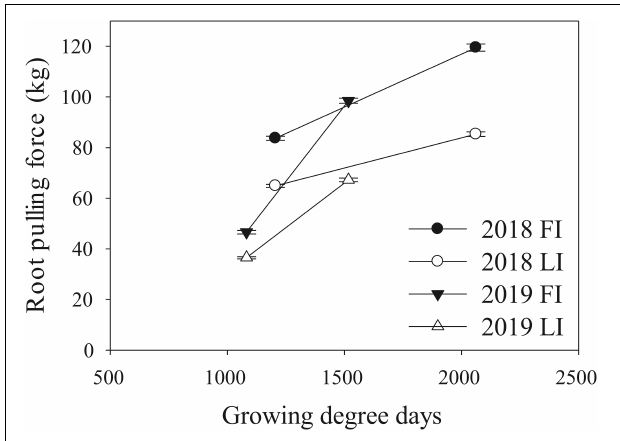
FIGURE 2 | Changes in RPF over the field growing seasons. Measurements for the two field seasons are given (mean ± SE) for the full (FI) and limited (LI) irrigation